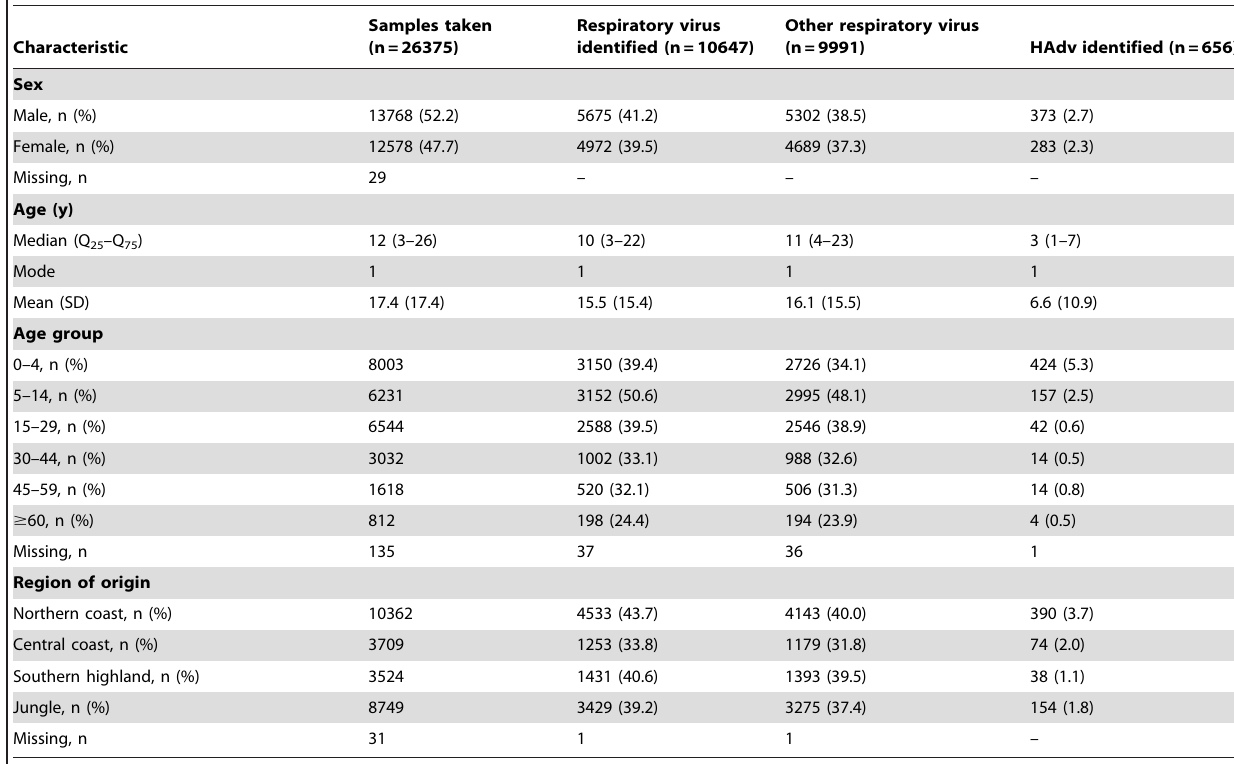
Table 1. Demographic characteristics of